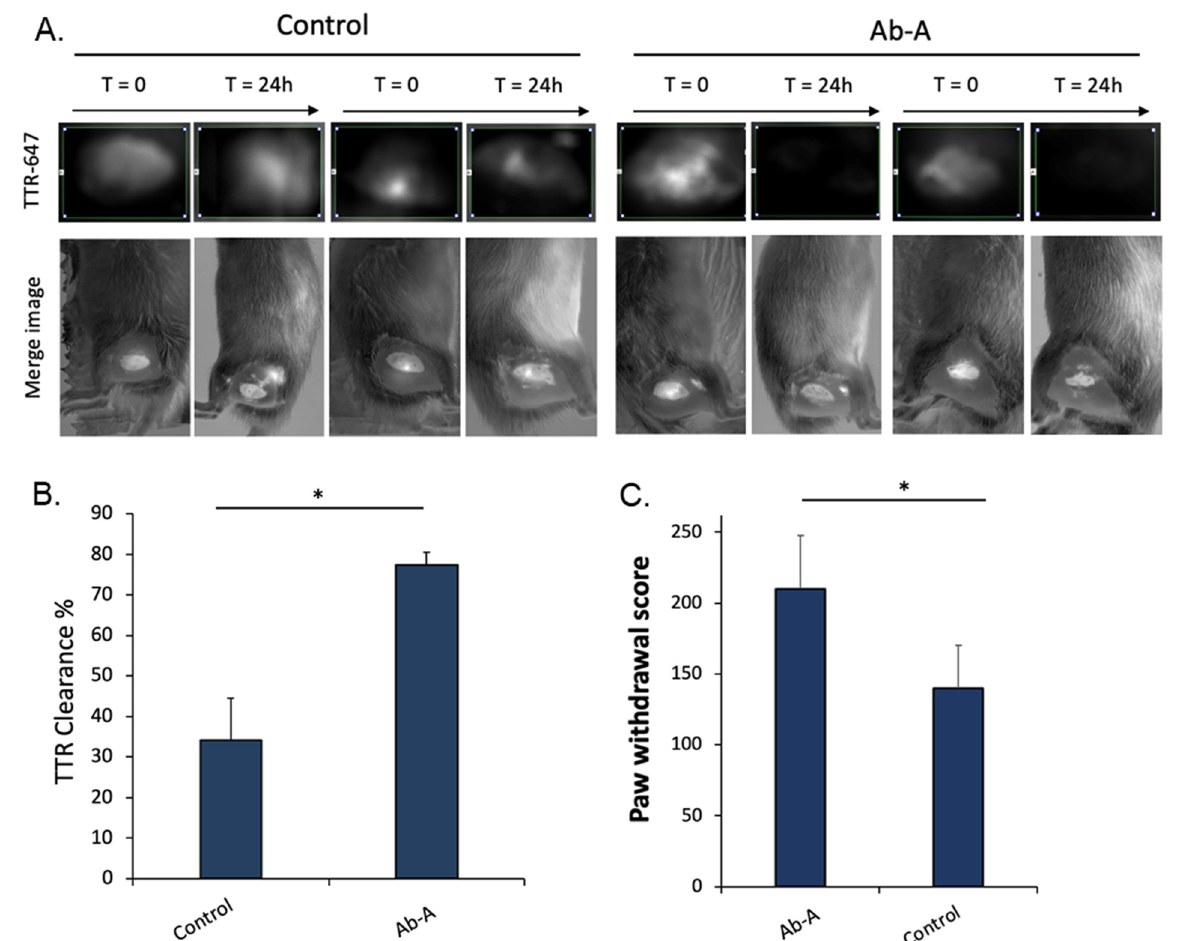
Figure 3. Ab-A produces the robust clearance of aggregated TTR and reduces neurologic damage in a model of ATTR polyneuropathy. ( A ) Aggregated TTR detected in rats by fluorescence imaging representative images. The rats in the left panel were treated with control IgG, and the rats in the right panel were treated with Ab-A. In each treatment group, there are two representative images showing TTR fluorescence before (T = 0) and after (T = 24 h) treatment. ( B ) Data from the image analysis of fluorescence imaging images quantitating TTR fluorescence in rats that received fluorescent TTR sciatic nerve injections and were treated with Ab-A or control IgG treatments. The y -axis represents the % clearance of TTR measured by fluorescence detection in the rat’s tissue 24 h after surgery (* p = 0.008). ( C ) Von Frey paw withdrawal score test performed 10 days post-operation in rats injected with aggregated TTR into the sciatic nerve, with and without Ab-A treatment (* p = 0.022). Results are presented as the mean ± SEM.